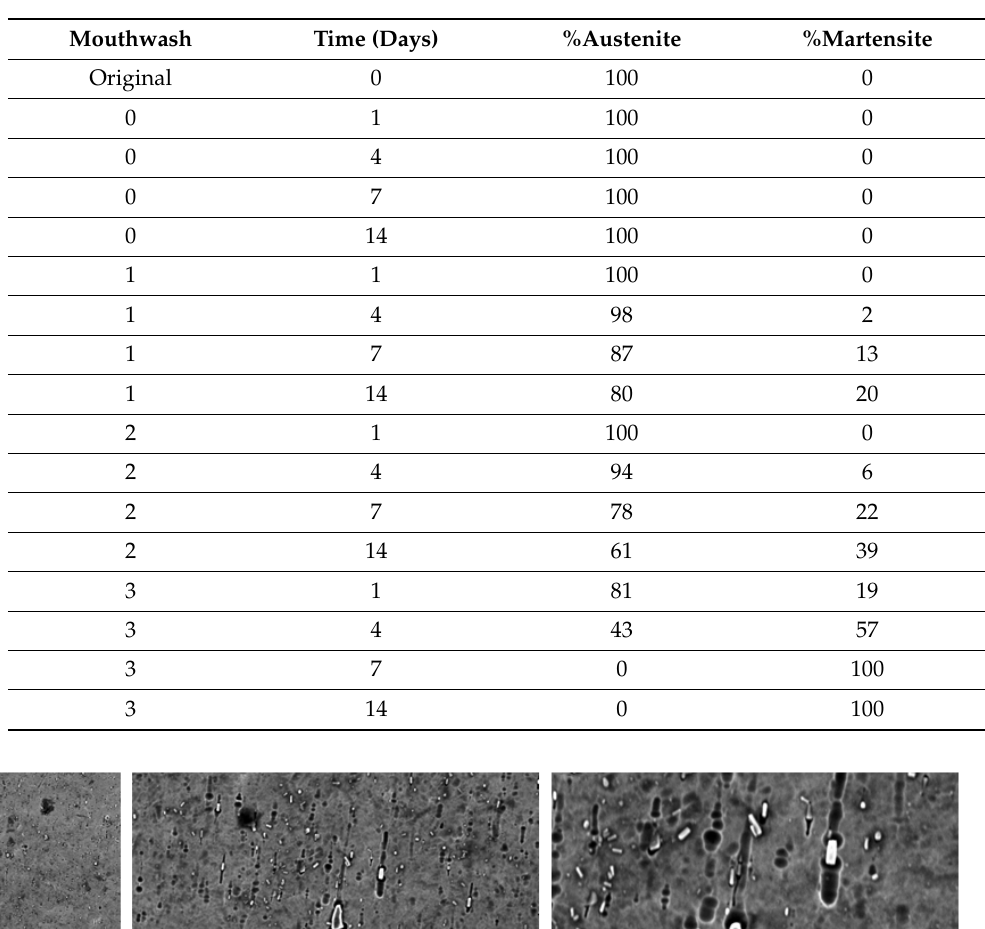
Table 2. Percentages of the austenite and martensite phases in orthodontic wires for each sodium fluoride content.